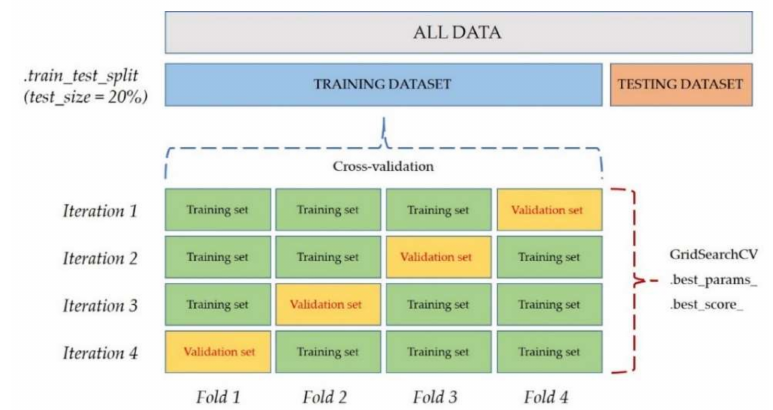
Figure 6. Cross-validation splitting on RE+NIR training dataset.